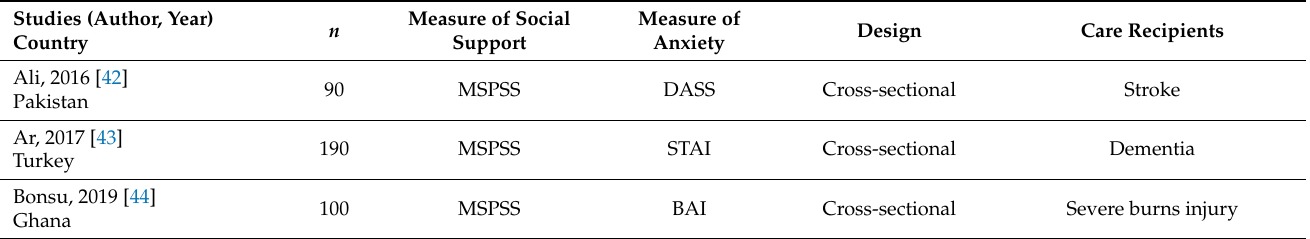
Table 1. Description of studies included in the